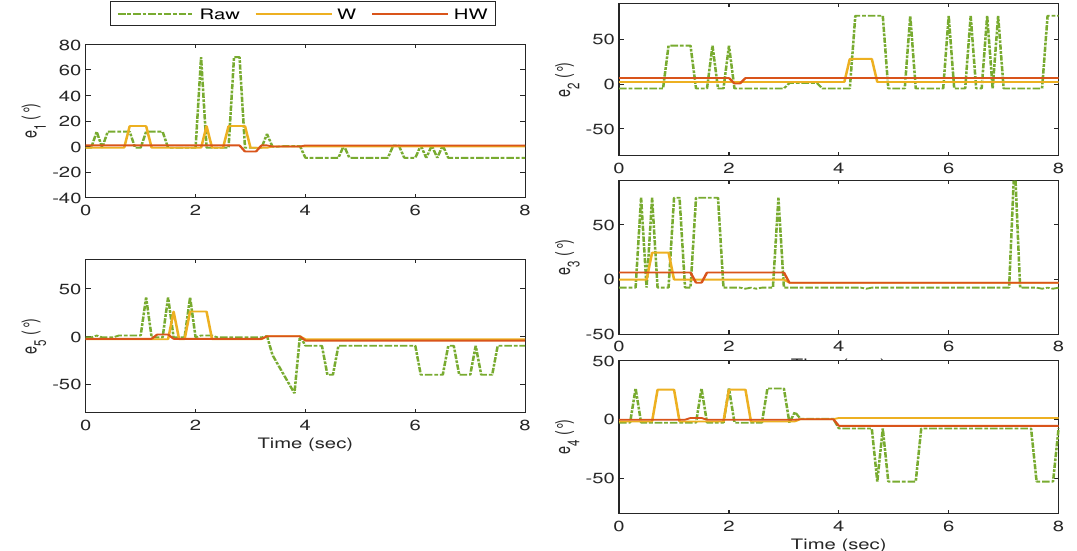
Figure 17. Gesture 2: The corresponding error from the response in Figure 16. The error due to the response from Compensator HW is significantly lower at all time instances as compared to the